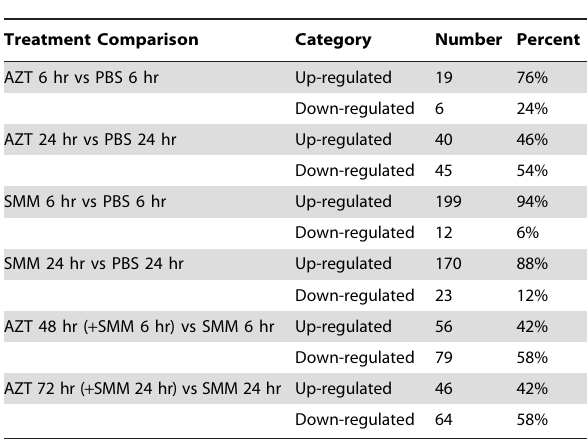
Table 4. Inflammation-related genes classified as up- or down-regulated as a function of treatment